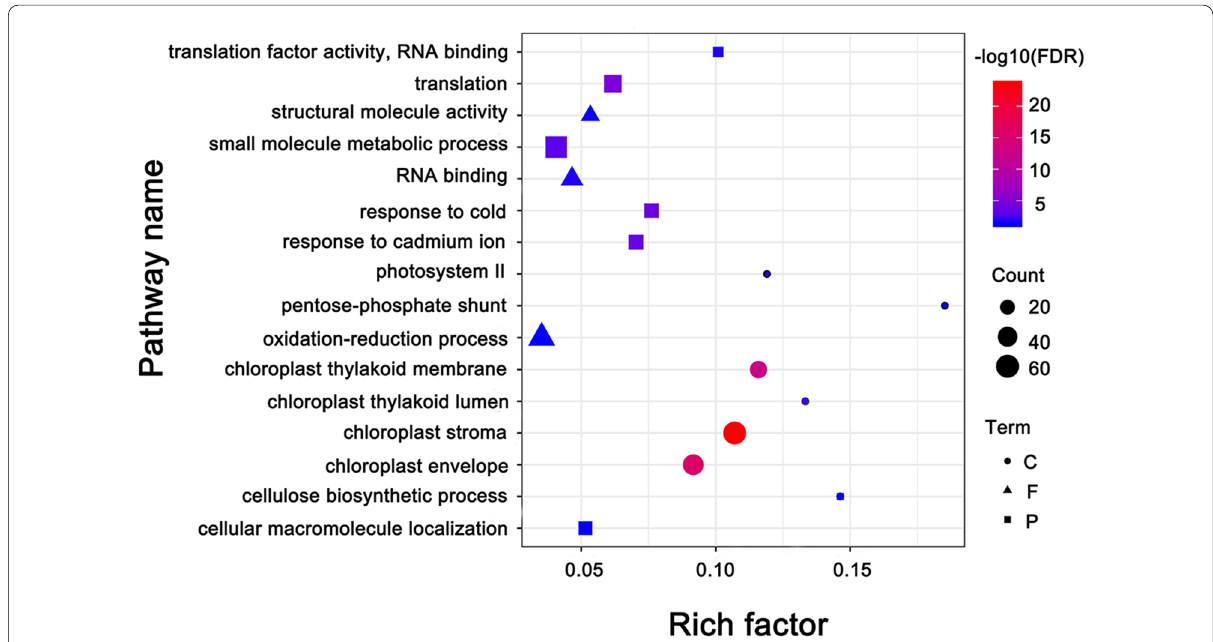
Fig. 5 GO enrichment of significantly differentially expressed